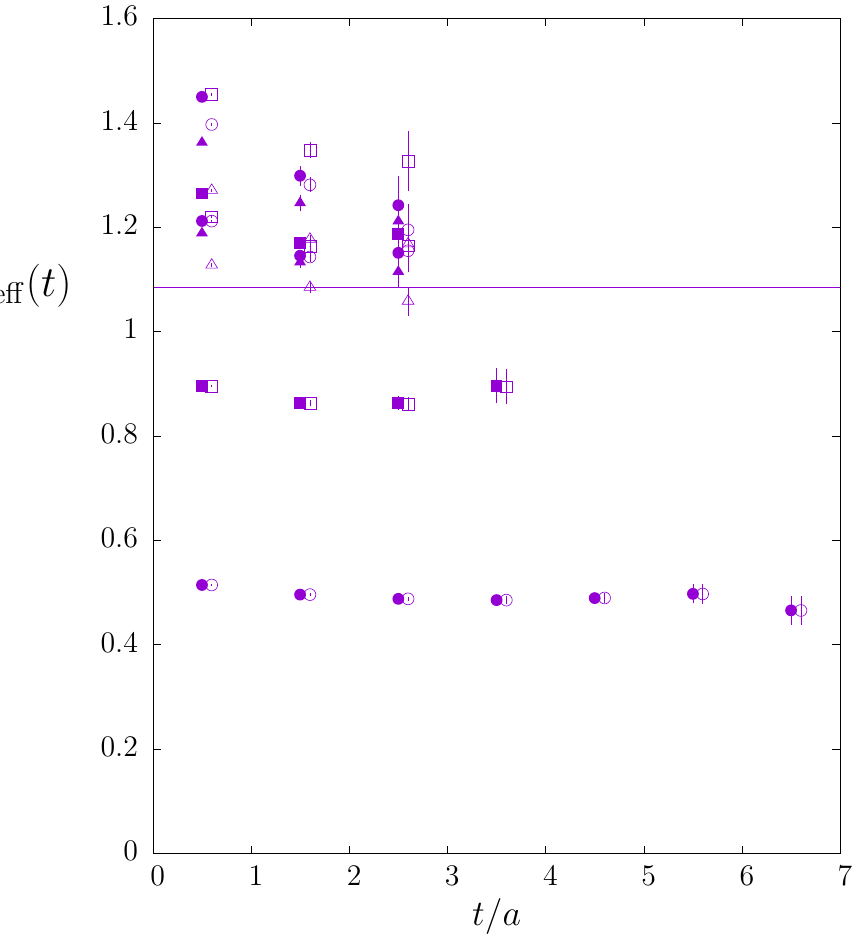
Figure 5 . Effective energies of the lightest A 1 ++ states from the basis of the usual single loop operators (filled points) and from the same basis but extended with our ditorelon operators (unfilled points). Horizontal line is the energy of the lightest ditorelon state neglecting interactions between the torelons. On a 26 3 26 lattice at β = 6 . 235